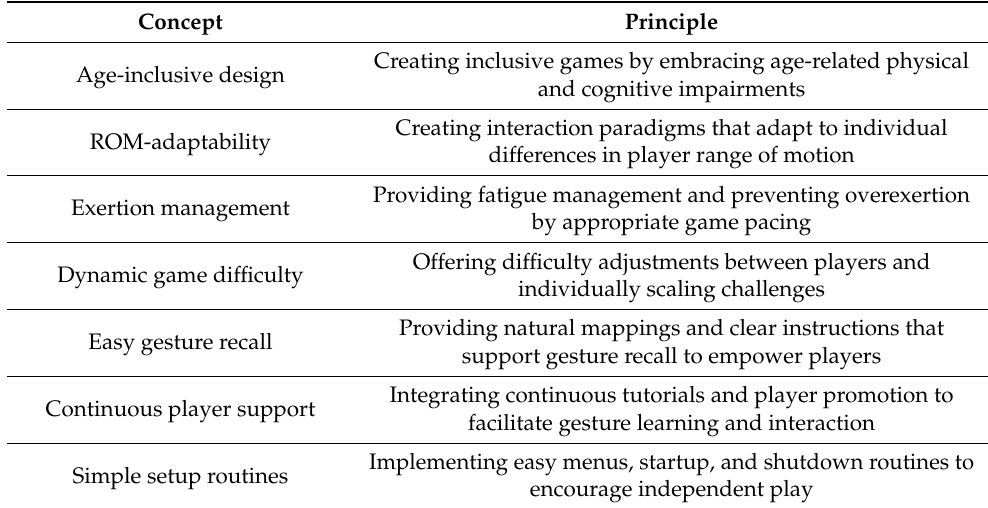
Table 2. Principles for designing exergames for the older adult proposed by Gerling et al.